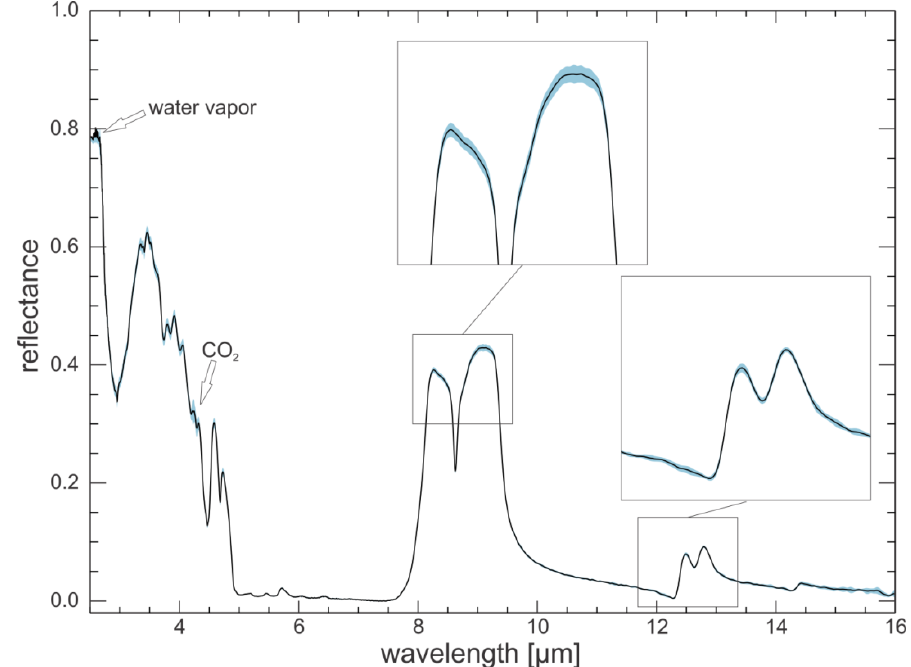
Figure 5. Ten day reproducibility test. Mean spectrum (black line) of 10 quartz sand measurements taken on ten days in a two week period, and the corresponding standard deviation (light blue band). Standard deviations are in the range 0.001 to 0.007 for most wavelengths.